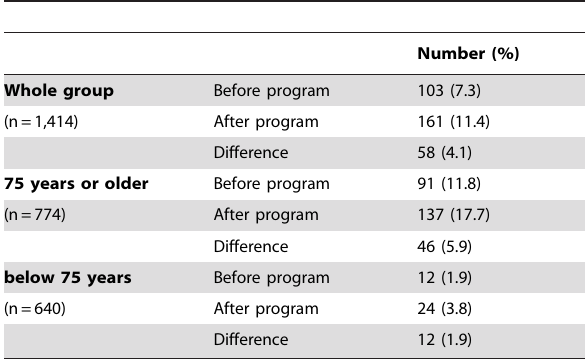
Table 2. Ownership of hearing aids (whole group and by age